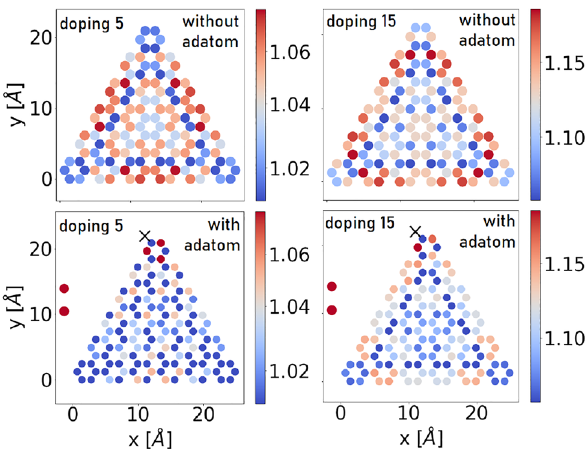
Figure 4: Upper row: Charge distribution due to the self-consistent density matrix 𝜌 sc of an armchair triangular graphene flake of 126 atoms doped with 5 electrons (left) or 15 electrons (right). Lower row: As in the upper one, but with an